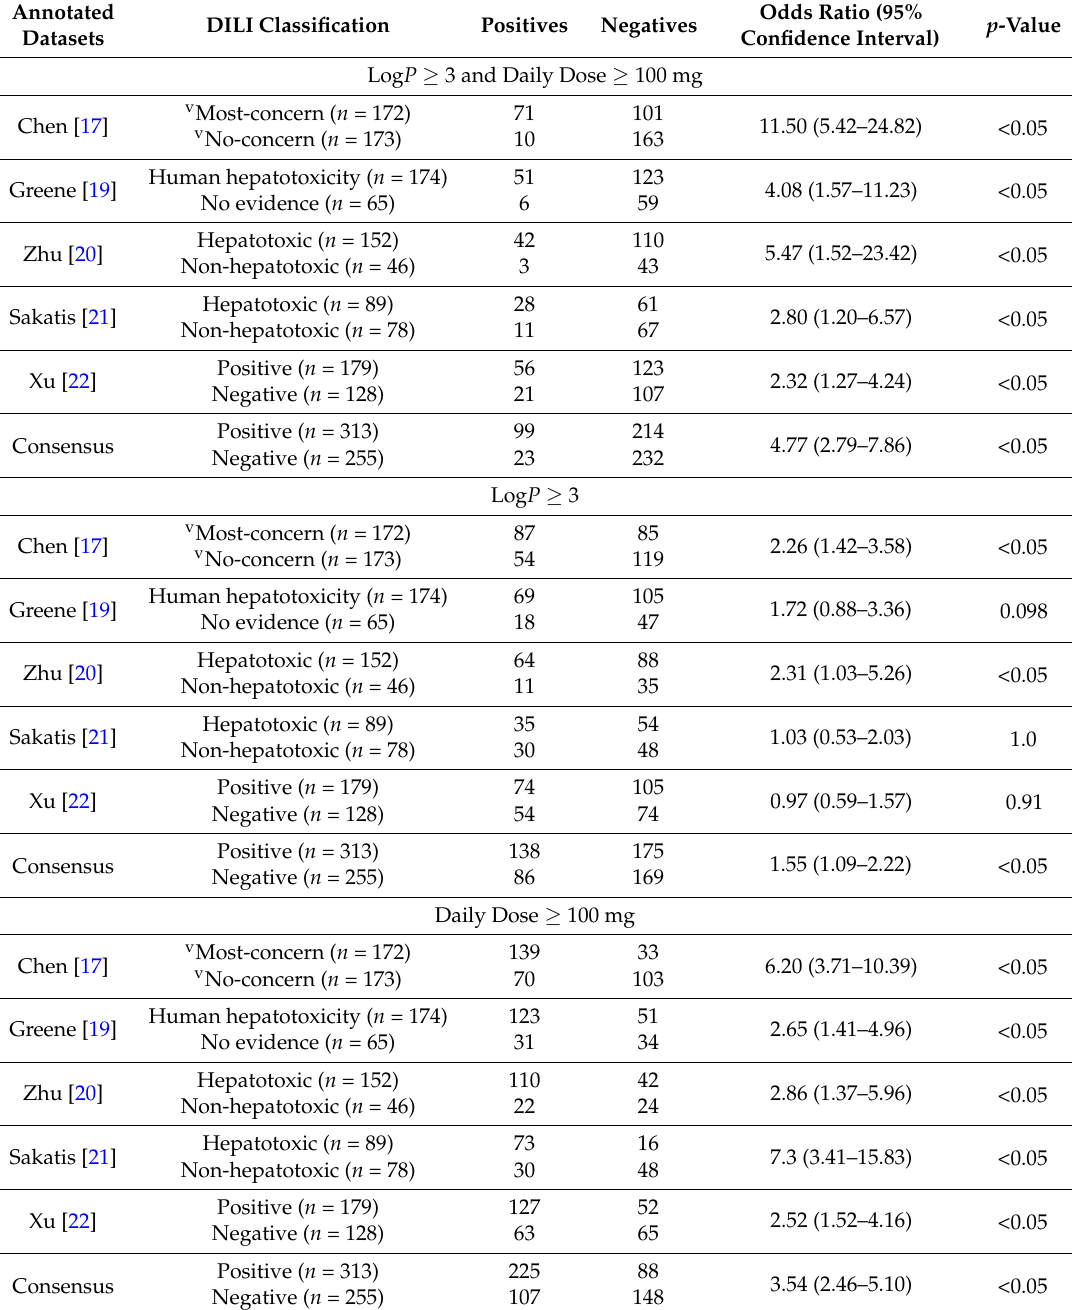
Table 1. The assessment of the relationship between DILI risk, lipophilicity, and daily dose.